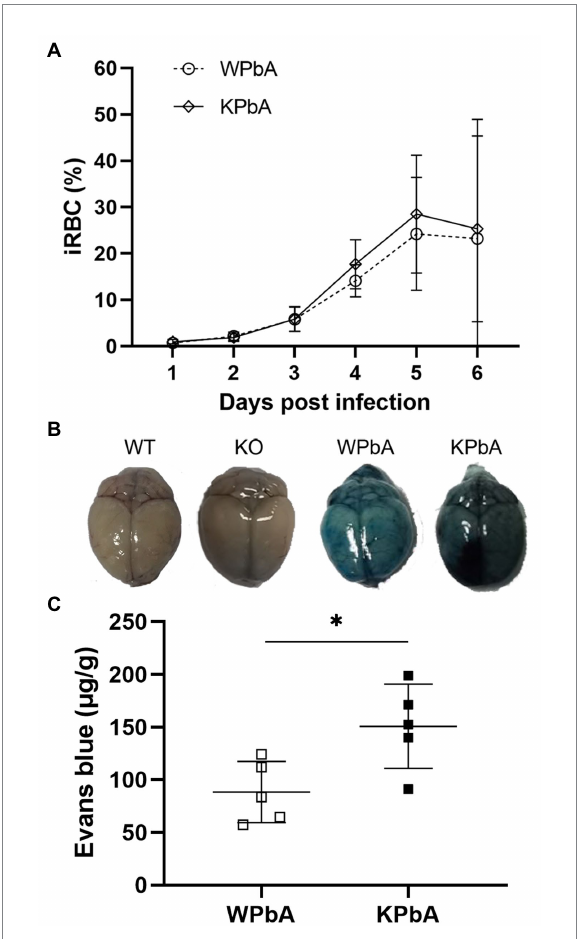
FIGURE 1 Differences in the pathology between WT and KO mice infected with PbA. (A) Parasitemia was monitored in both the WPbA and KPbA groups, daily. Parasitemia values represent the means ± SD from 10 mice in each group. (B) Mice were injected intravenously with Evans blue at 6 dpi. Uninfected mice were used as controls. (C) The amounts of EB per g of brain from infected mice are shown ( n = 5). Statistical analysis was performed using the T -test. * p <